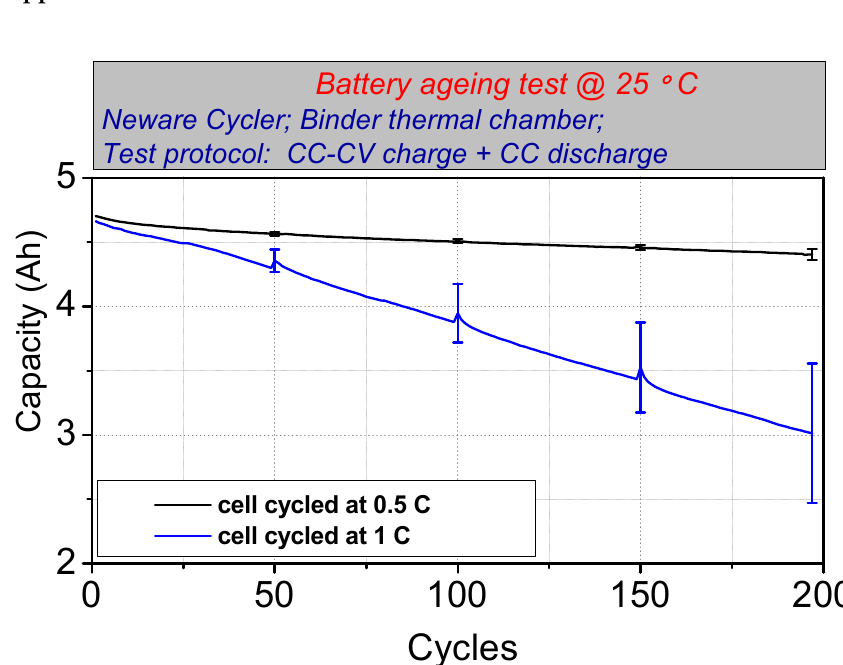
Figure A1. Battery capacity in the 25 °C cycling ageing test.